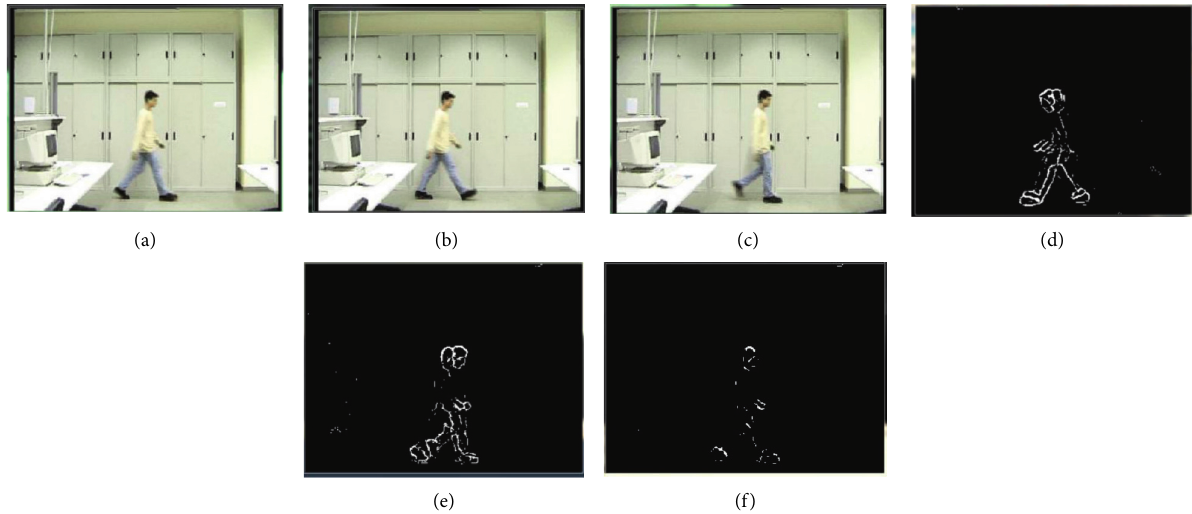
Figure 4: Three-frame difference experiment results. (a) Frame 97. (b) Frame 98. (c) Frame 99. (d) Frames 97 and 98, (e) Frame 98 and frame 99. (f) Three-frame.